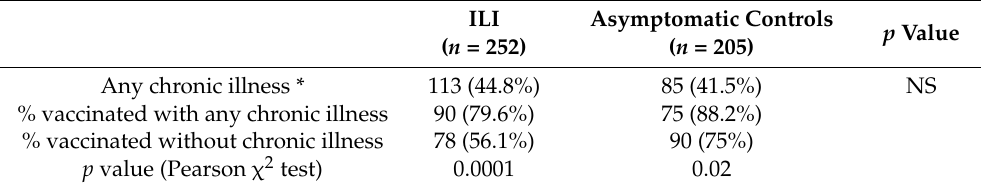
Table 2. Occurrence of chronic illness in combination with vaccination